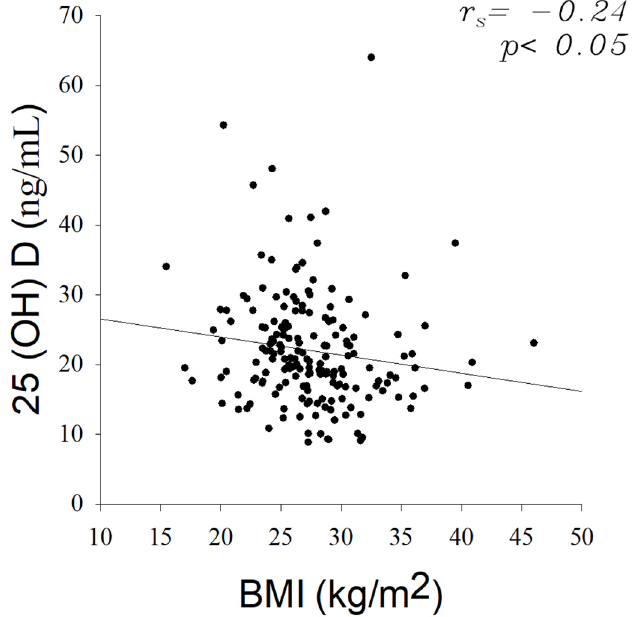
Figure 1. Scatterplot of body mass index (BMI) vs. plasma 25-hydroxyvitamin D. Spearman´s correlation coefficient is presented in the figure at p < 0.05.